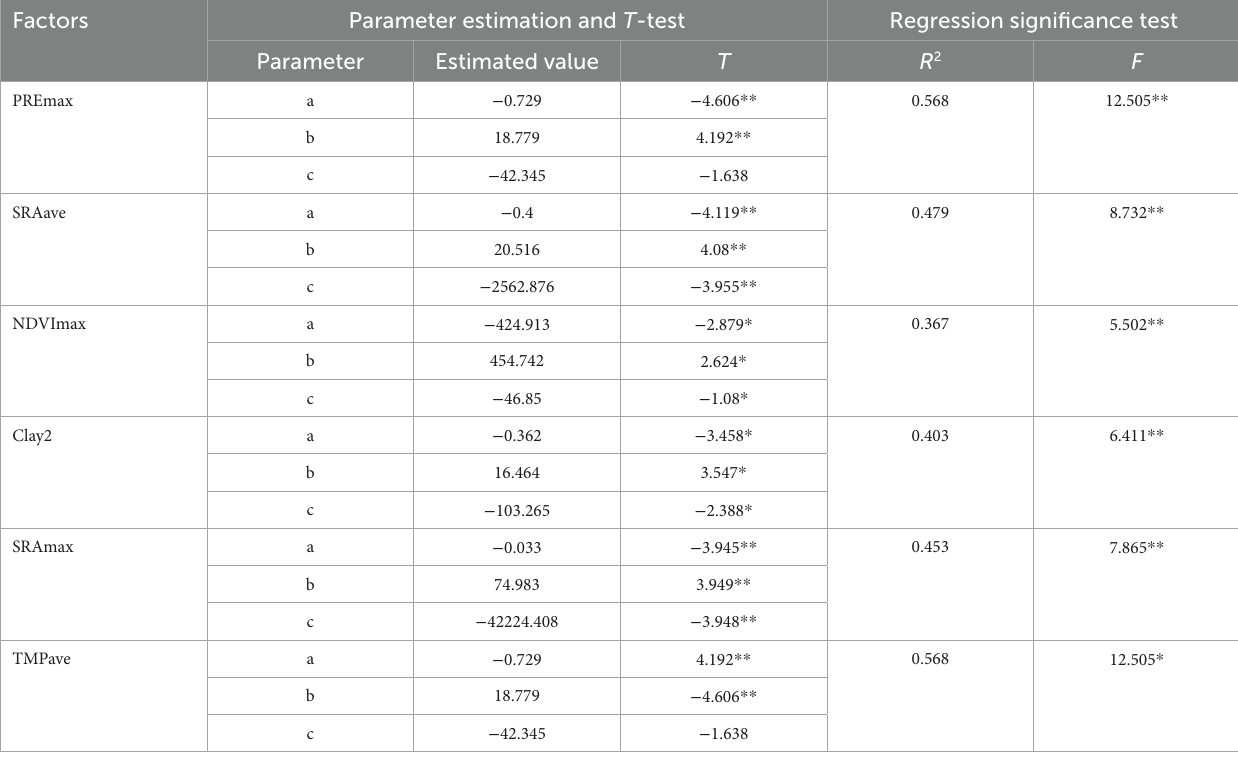
TABLE 3 Results of models fitting with the optimum estimation models. Factors